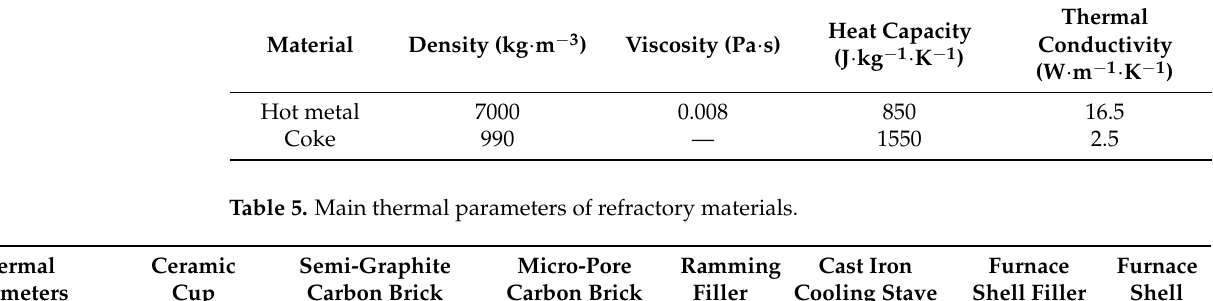
Table 4. Main physical parameters of hot metal and coke.